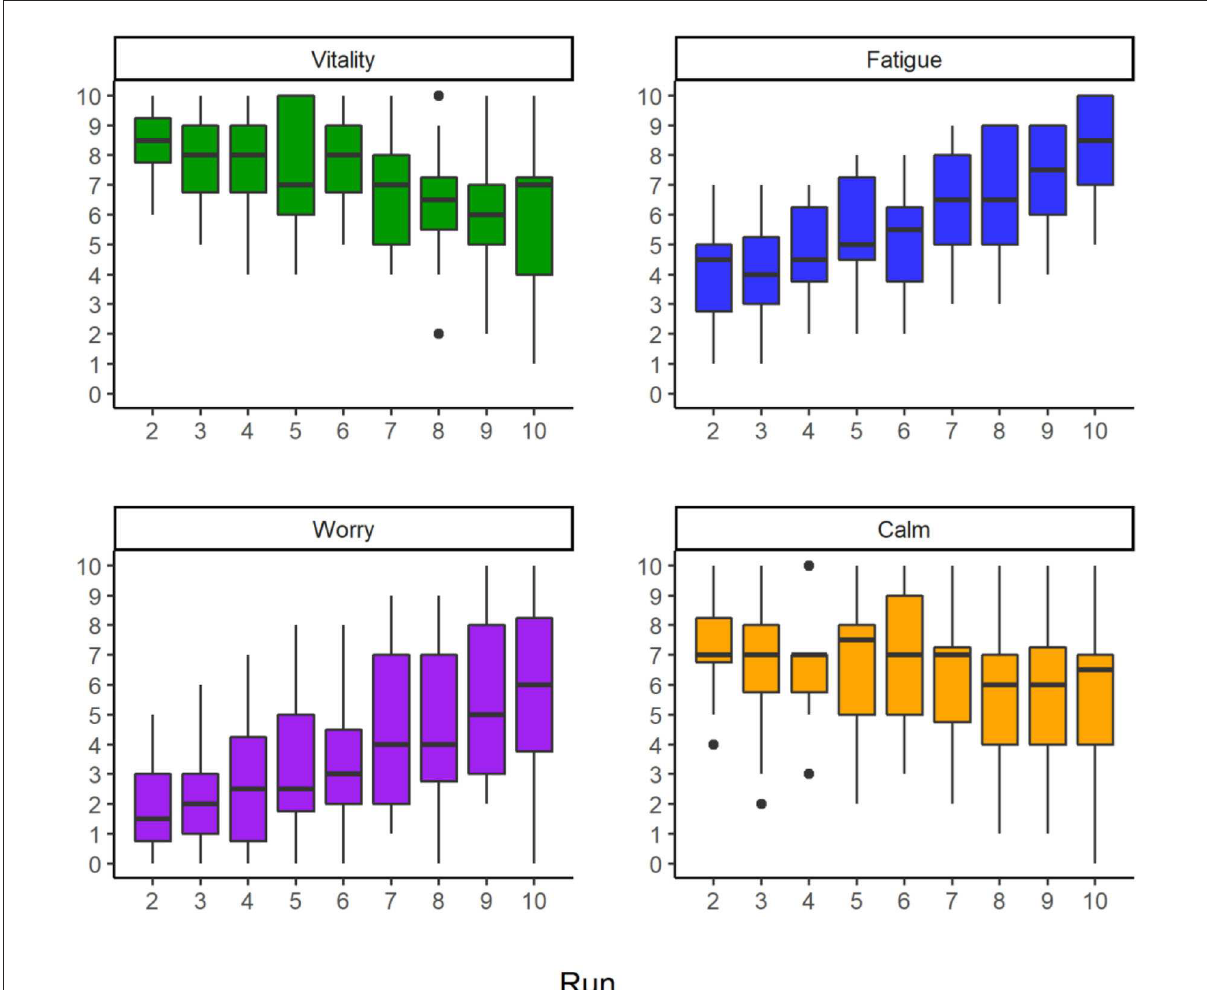
FIGURE2 Boxplots including outliers (1.5 times of the interquartile range) indicated as black dots of subjective parameters ( n = 16) per run.